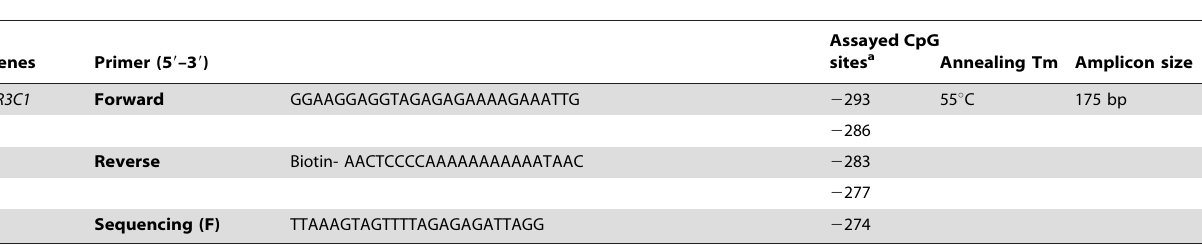
Table 1. Primers for bisulfite polymerase chain reaction and